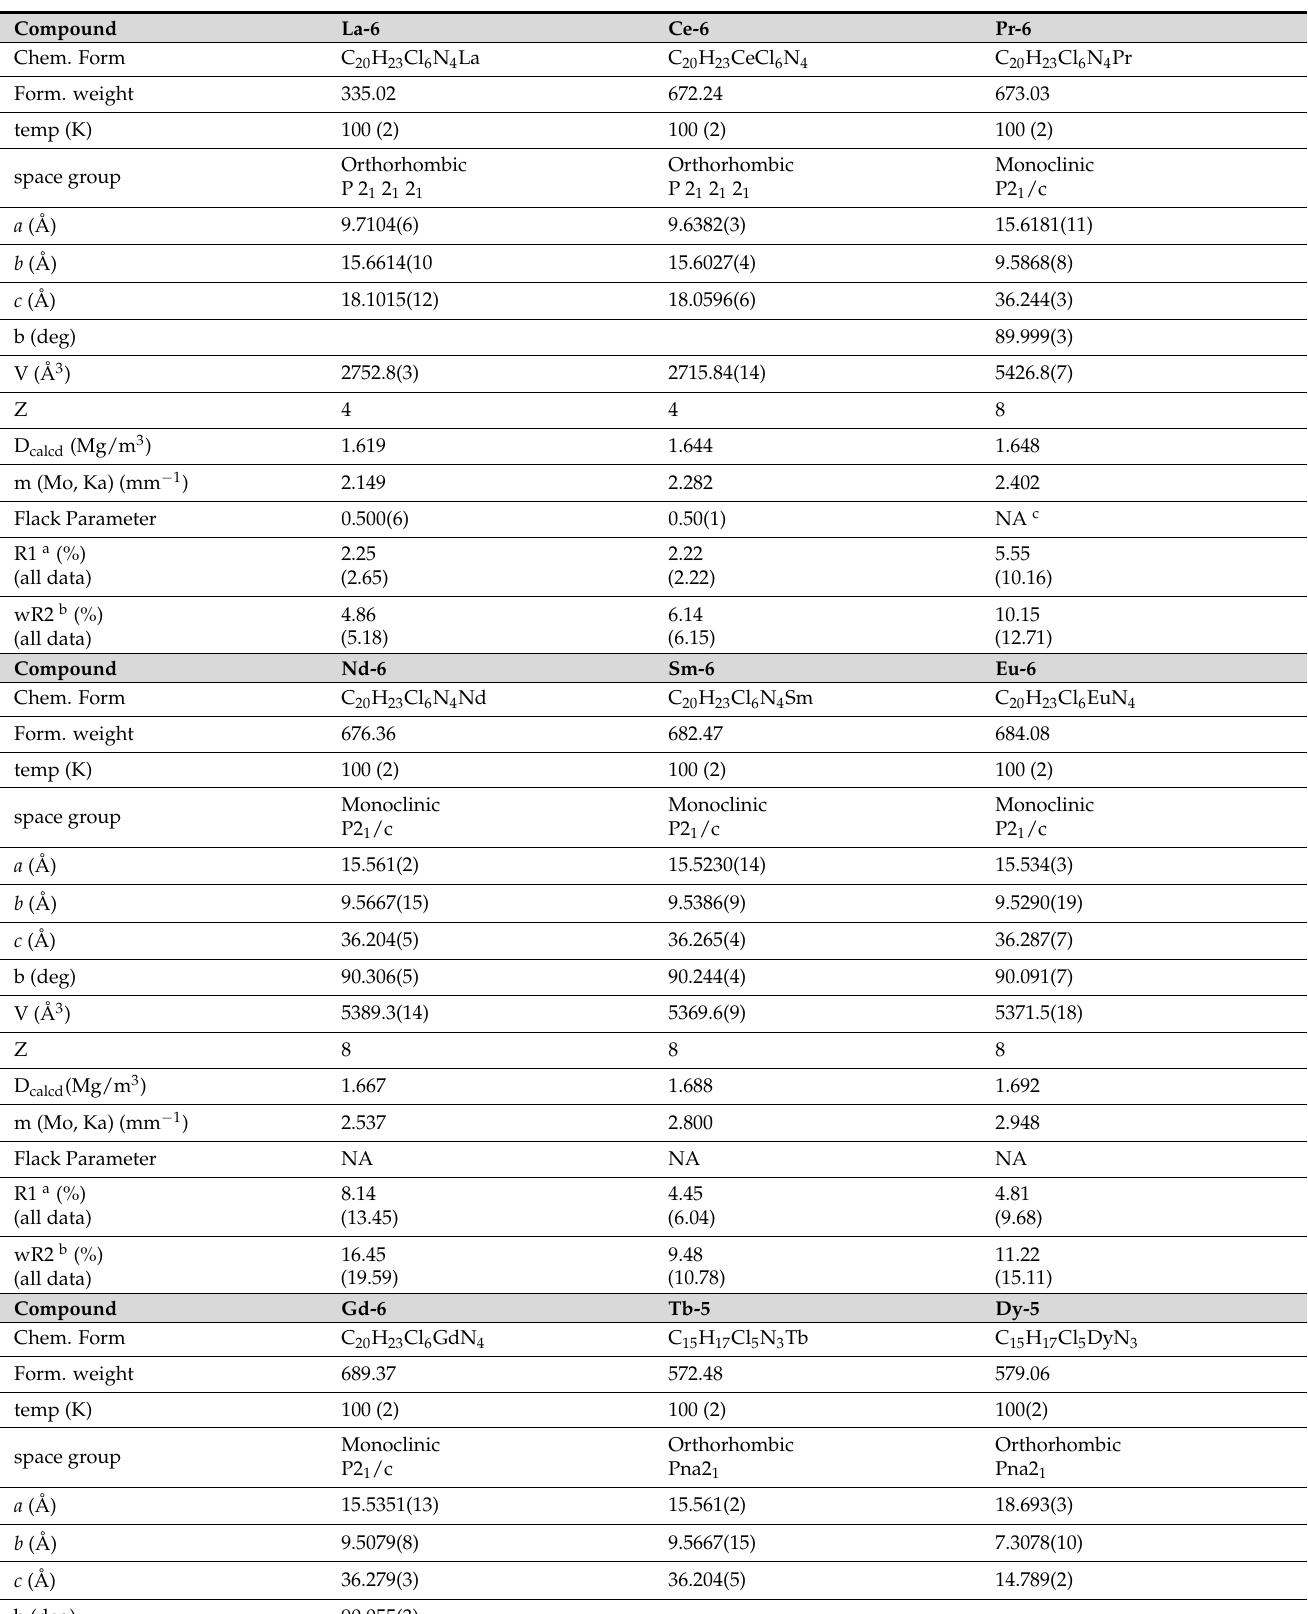
Table 1. Data collection parameters for La-6 to Ce-H 2 O